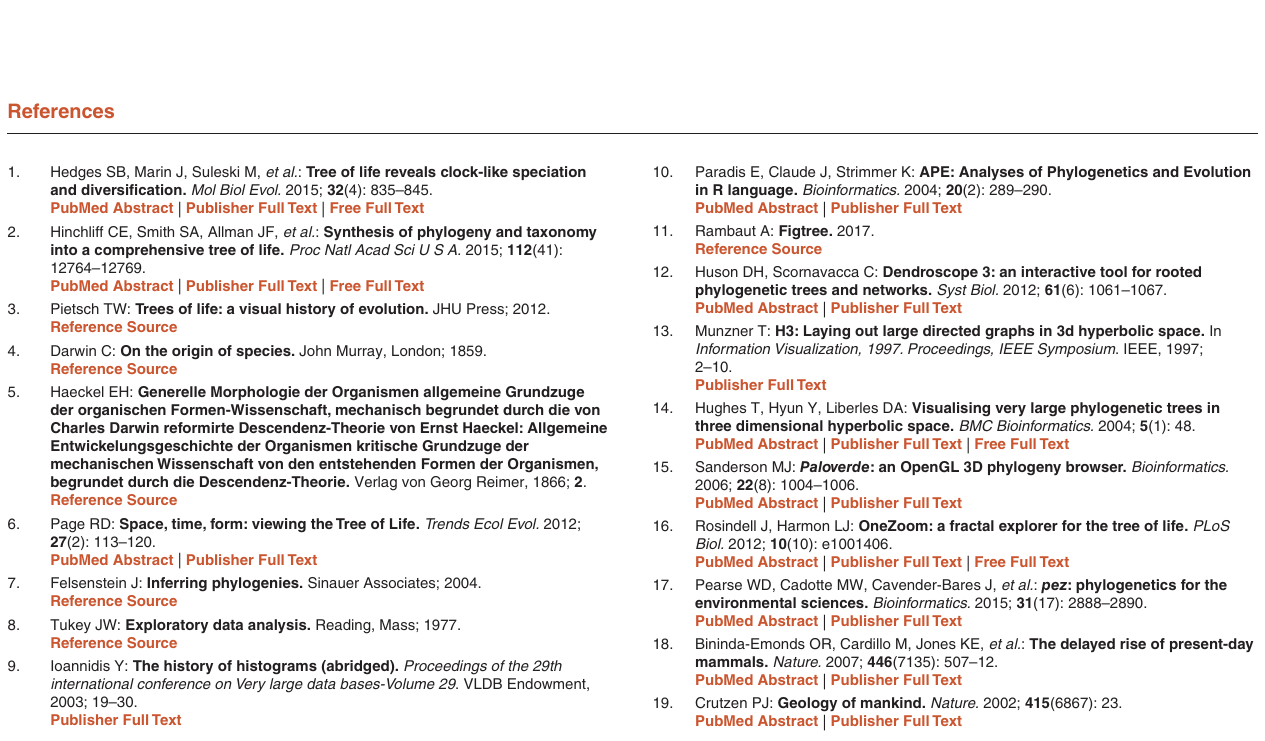
Supplementary File 1: R code for fibre plot Click here to access the